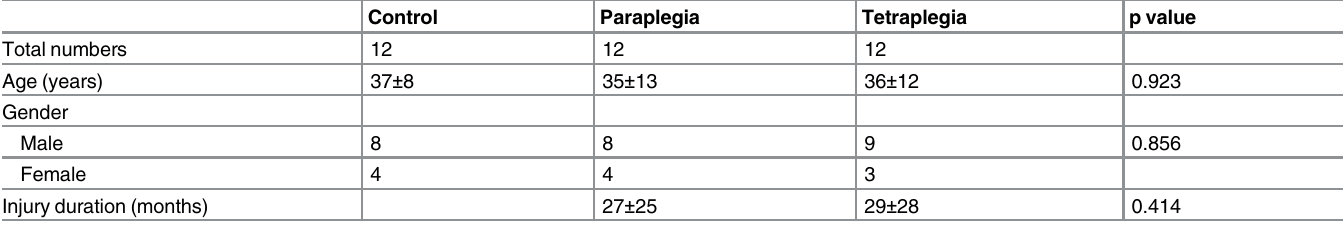
Table 1. Basic demographic data of our